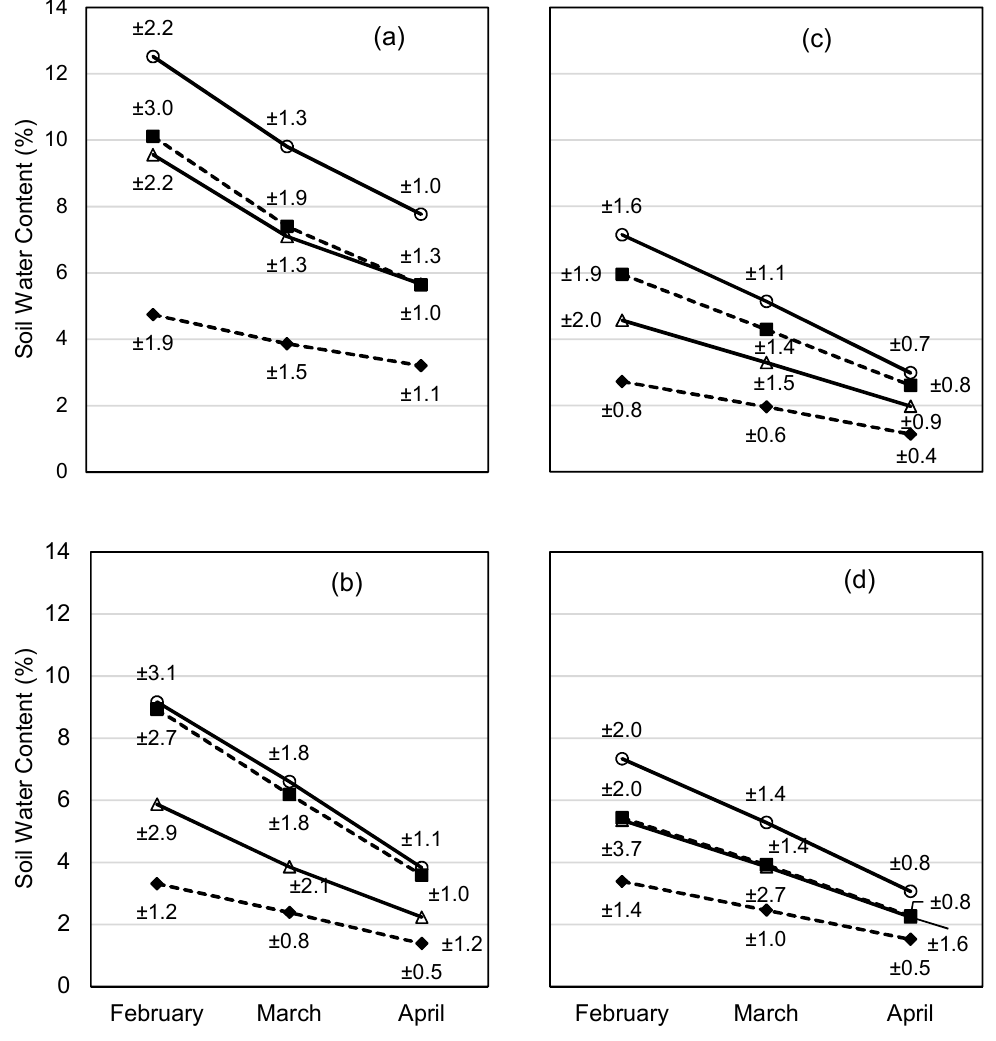
Figure 3. Soil water content (SWC) on the four sites: ( a ) Teshi; ( b ) Ruba Feleg; ( c ) Michael Emba; and ( d ) Enda Chena. The numbers close to the points indicate the standard deviation. Table 4. Average SWC (in kg / kg) of the four sites evaluated in the four di ff erent position of soil samples collection. The same lower-case letters on the columns and upper-case letters on the rows indicate